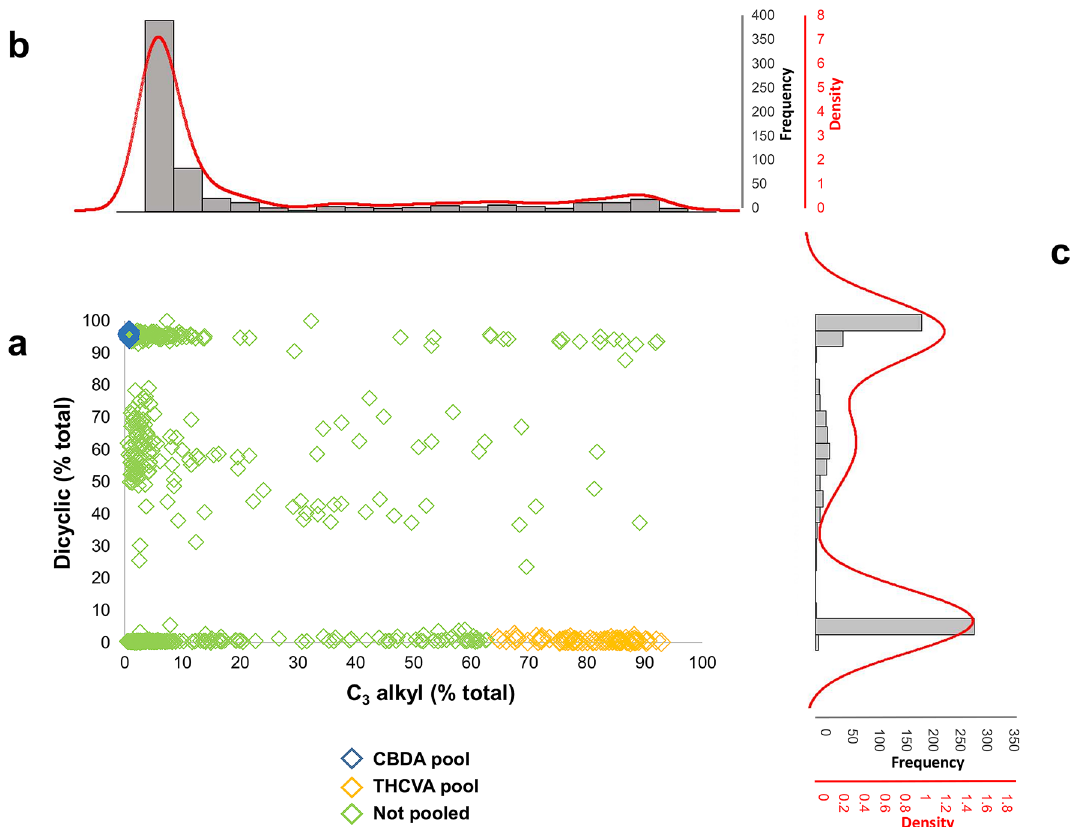
Figure 1. Chemotypic distribution of cyclic and alkyl cannabinoid composition in 711 Cannabis sativa L. plants. ( a ) Scatter plot showing distribution of bi-axial cannabinoid chemotypes. ( b ) Histogram and kernel density estimates of C 3 -alkyl cannabinoid chemotypes. ( c ) Histogram and kernel density estimates of dicyclic cannabinoid chemotypes. Plants within the diversity panel were selected from the Ecofibre Global Genetic Resource Collection. Cannabinoid composition was determined from liquid chromatography-mass spectrometry (LC–MS). Dicyclic and C 3 -alkyl cannabinoid fractions within the total cannabinoid fraction were calculated from fresh weight ( w/w ) cannabinoid content. Alkyl cannabinoid values are skewed towards low C3-alkyl, while dicyclic values exhibit a tripartite chemotypic distribution. Blue diamond (CBDA) and yellow diamond (THCVA) data points represent individual plants selected for an extreme-phenotype genome-wide association study.